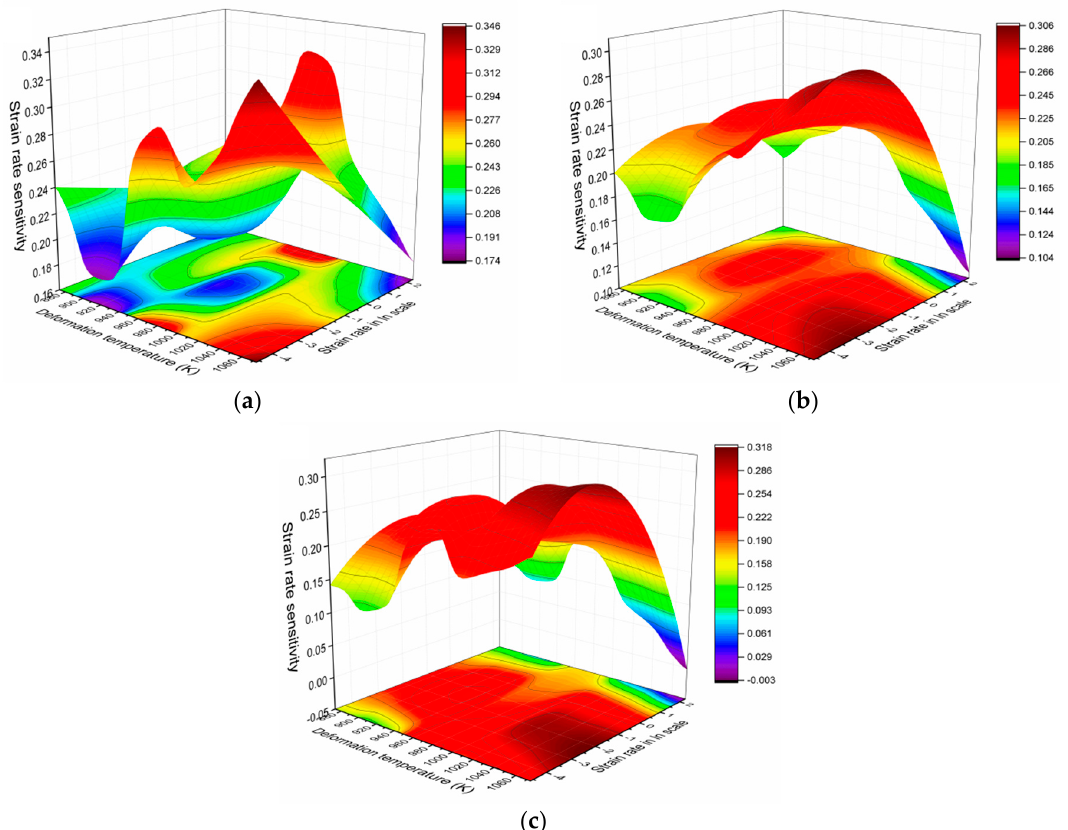
Figure 6. The relation between true stress and strain rate using ln scale, ( a ) = 0.9.